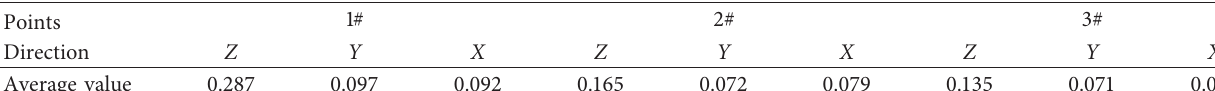
Figure 9: Time history curves of vertical accelerations: (a) top of the rail foot; (b) bottom of the rail foot; (c) track bed; (d) tunnel wall. Table 4: Average peak accelerations of 1# ∼ 3# (unit: m/s 2 ).